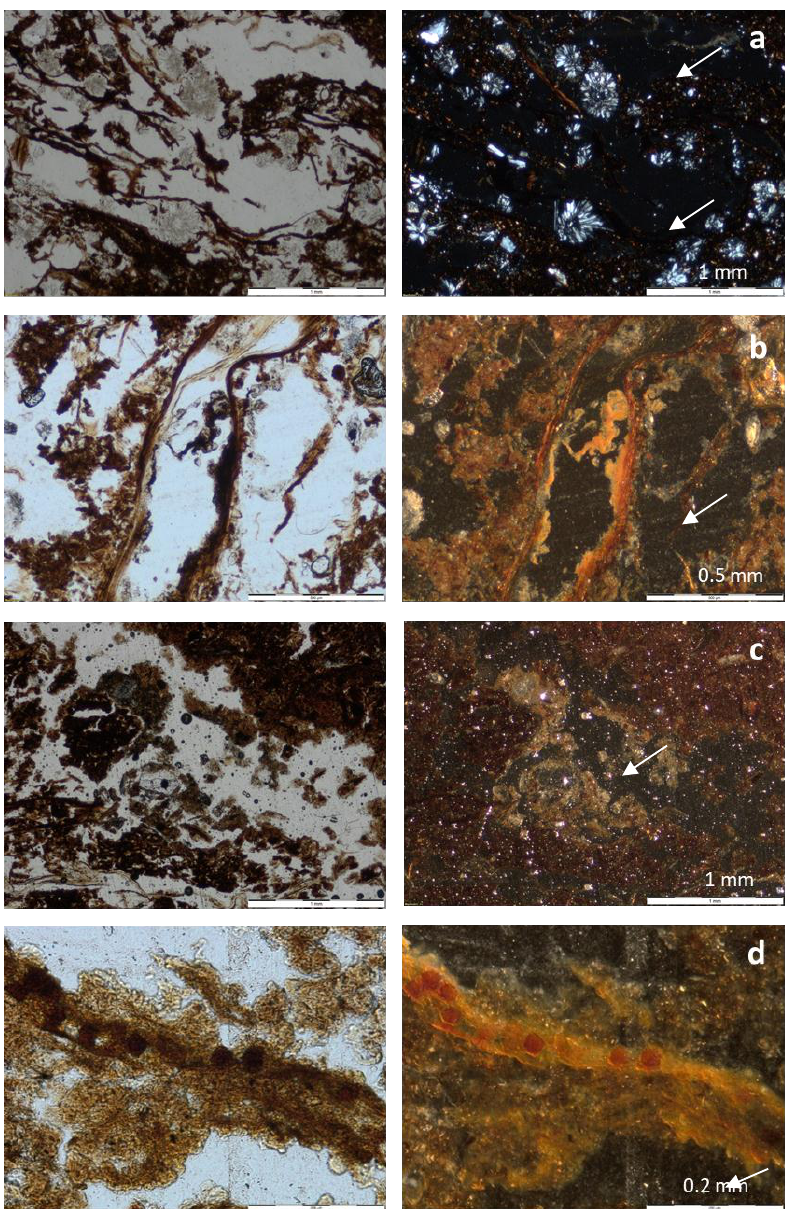
Figure 2. Microphotographs of selected features: ( a ) Gypsum rosettes in profile 1 (left: Parallel polarizers (PPL), right: Crossed polarizers (XPL)); ( b ) jarosite coating in a plant residue, profile 1 (left: PPL, right: Oblique incident light (OIL)); ( c ) jarosite hypocoating of around a pore, profile 2 (left: PPL, right: OIL); ( d ) iron oxide nodules, possibly pseudomorphs after pyrite framboids, profile 2 (left: PPL, right: OIL). PPL: Parallel polarizers, XPL: Crossed polarizers, OIL: Oblique incident light.